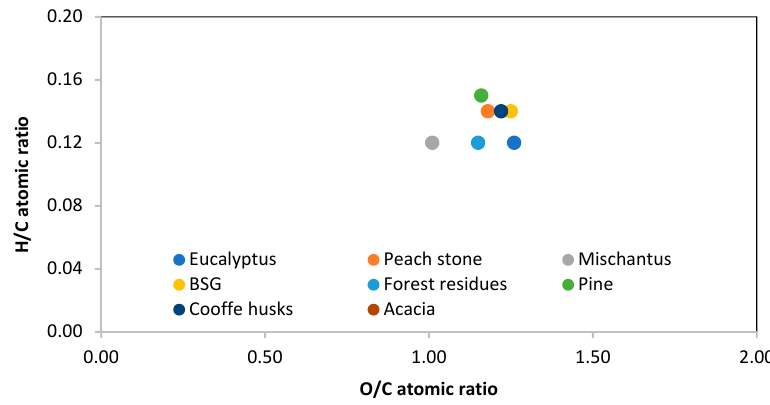
Figure 4. Van Krevelen diagram for various biomasses.